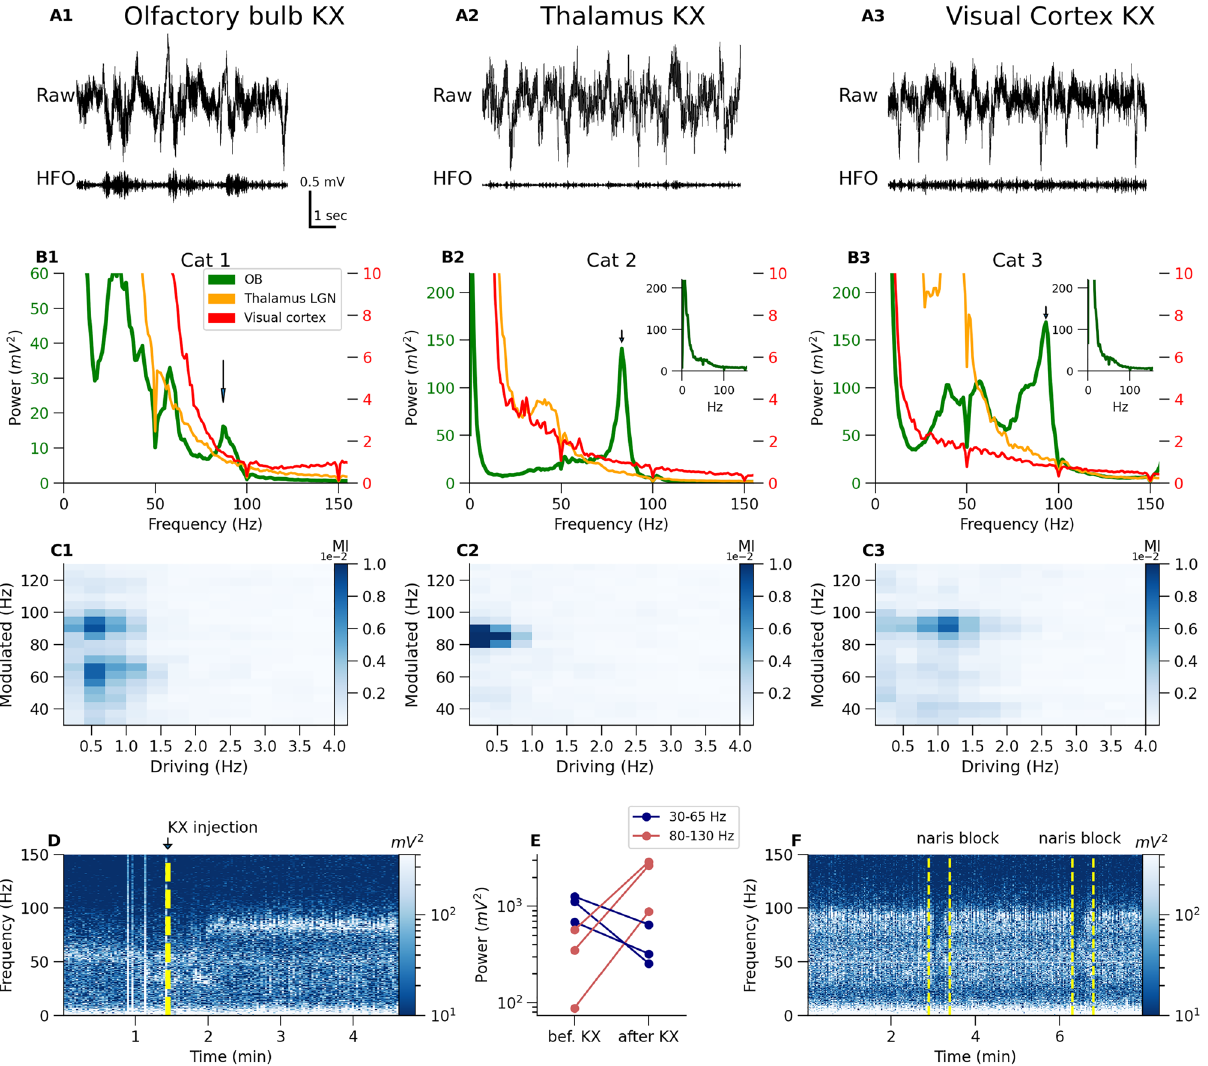
Figure 6. KX-dependent 80–130 Hz oscillations occur in the OB, but not thalamus or visual cortex of cats. ( A ) Example raw waveforms from one cat from three different brain regions. Raw signal is presented in top rows and 80–130 filtered signal is in bottom row. ( B ) Power spectrum from 10 min of recordings. We observed ∼ 90 Hz distinct band in OB power spectra of all three cats (indicated on the power spectra by an arrow). In one cat with an electrode in the posterior OB the power of this rhythm was smaller (cat 1). There was no clear peak in the power spectra corresponding to this activity in the thalamus or visual cortex. There is separate y-scale for OB power (green, left) and for thalamus and visual cortex (red, right). Propofol anesthesia attenuated 80–130 Hz activity in the OB (insets, cat 2 and cat 3). ( C ) Modulation index score computed from single OB channels for all three cats. Color strength of the ’pixel’ represents power of the modulation for a given slow (driving frequency) and fast (modulated frequency) oscillation extracted from the raw signal. ( D , E ) show the rapid effect on OB oscillatory activity after supplementary infusion of KX, associated with increased power of the 80–130 Hz band with parallel decrease of the power of 30–65 Hz activity. The same phenomena were observed in rats; compare Fig. 1. ( F ) shows the effect of unilateral naris blockade of a cat which was associated with a reduction in 80–130 Hz